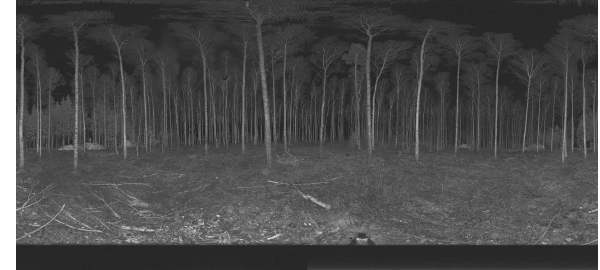
Figure 3: True 2D intensity